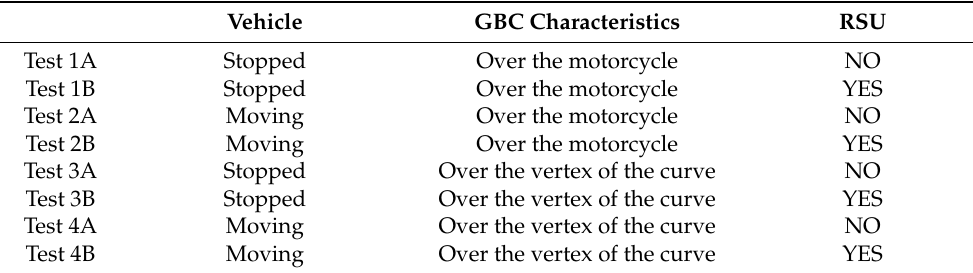
Table 1. Distribution